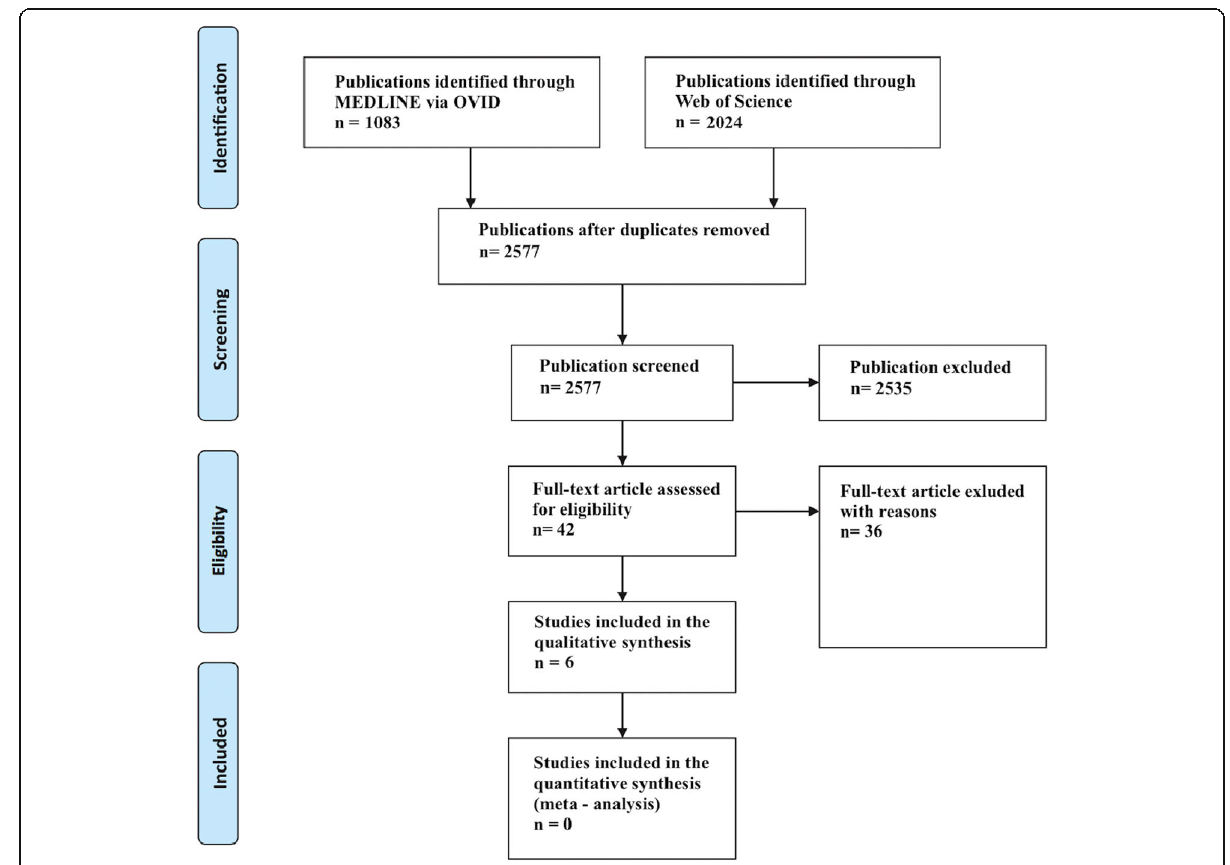
Fig. 1 PRISMA flow diagram of the screening and selection process. Reasons for exclusion are shown in Table